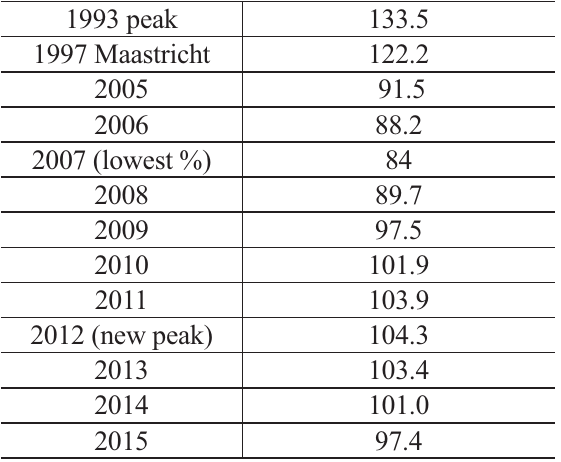
Table 2. Evolution of the Belgian Public Debt as a % of